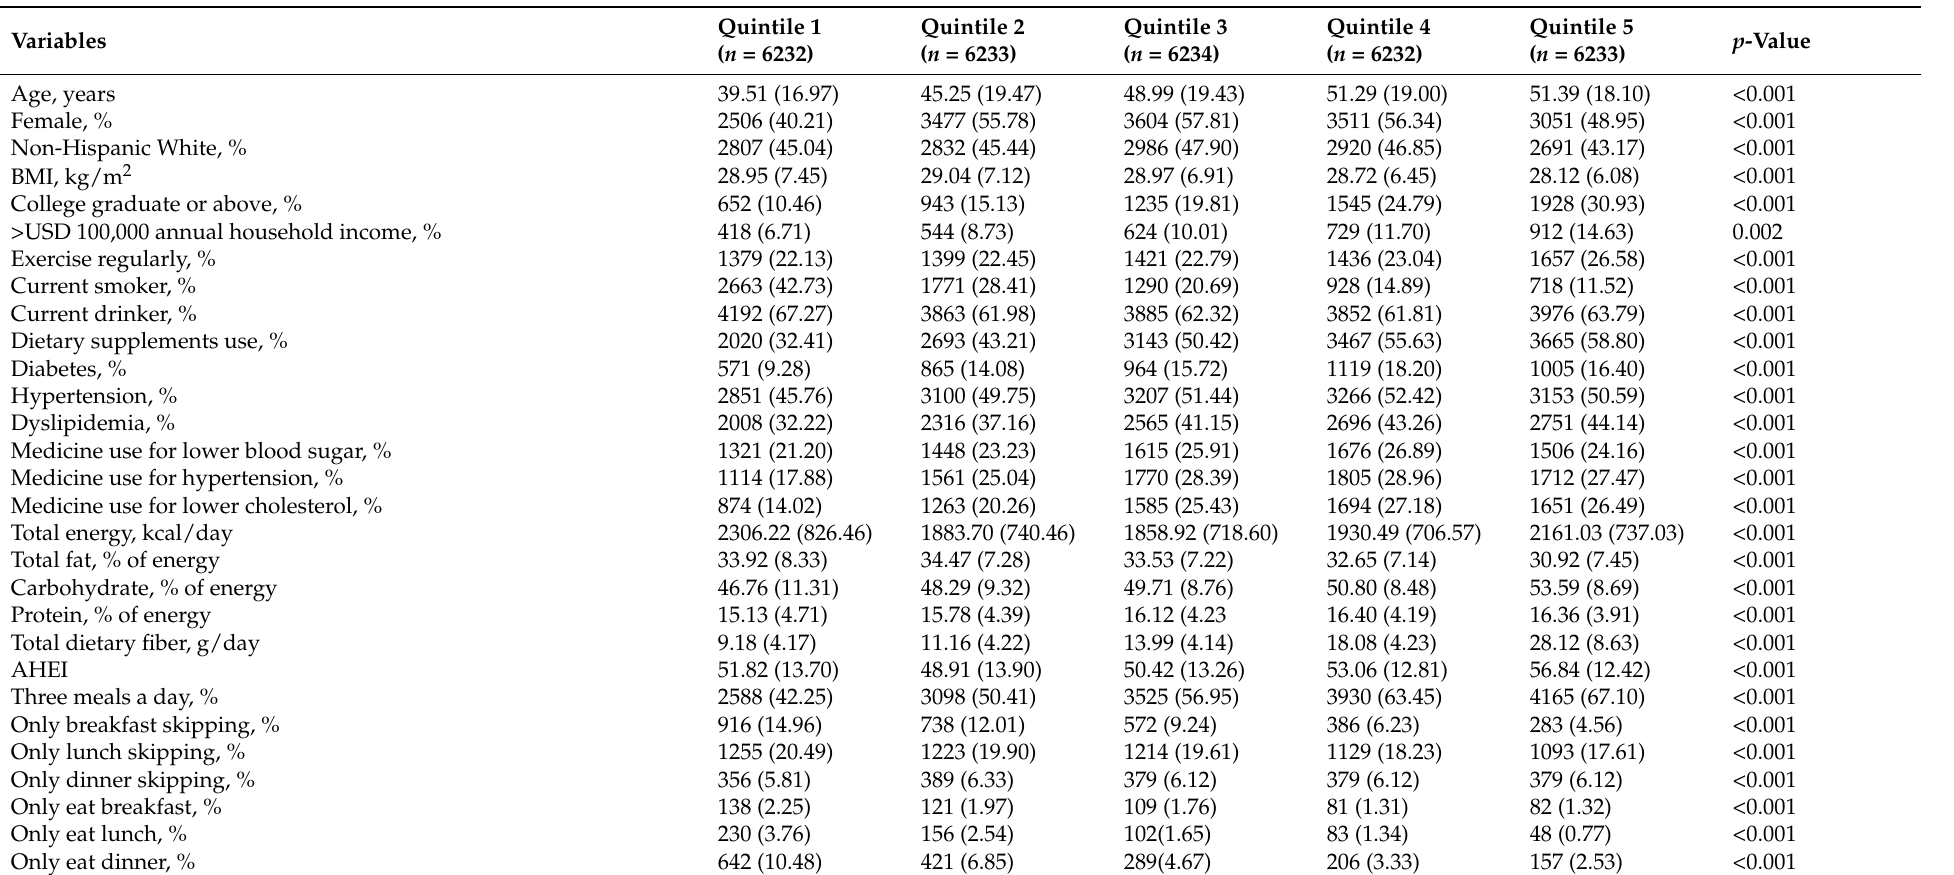
Table 1. Baseline characteristics of participants according to quintiles of total dietary fiber intake by the residual method among adults in the NHANES,